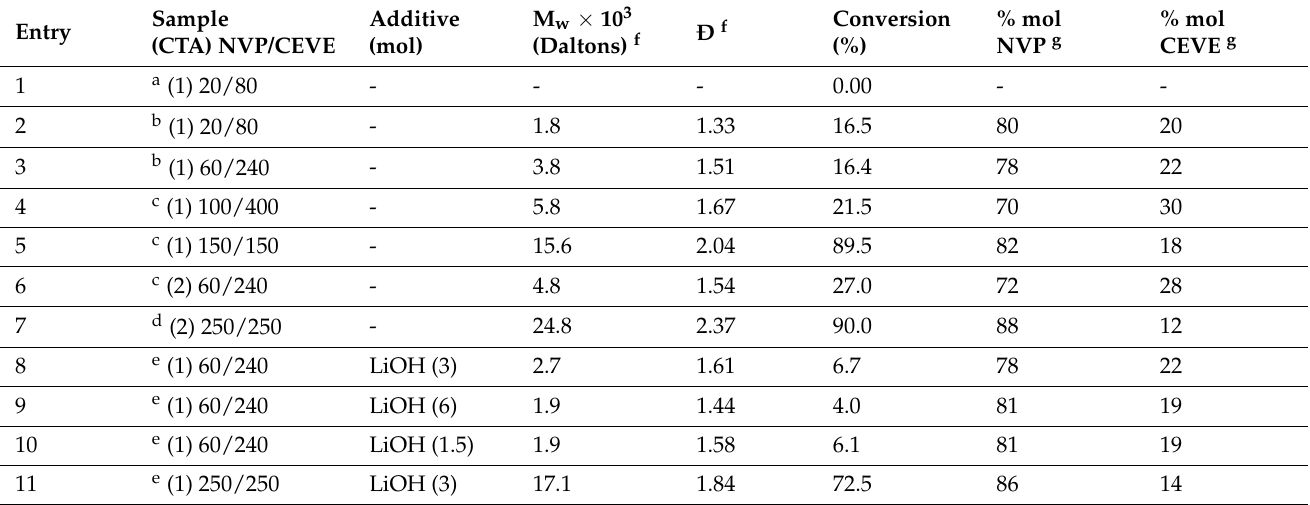
Table 1. Molecular characteristics of statistical copolymers P(NVP–stat–CEVE) via Radical